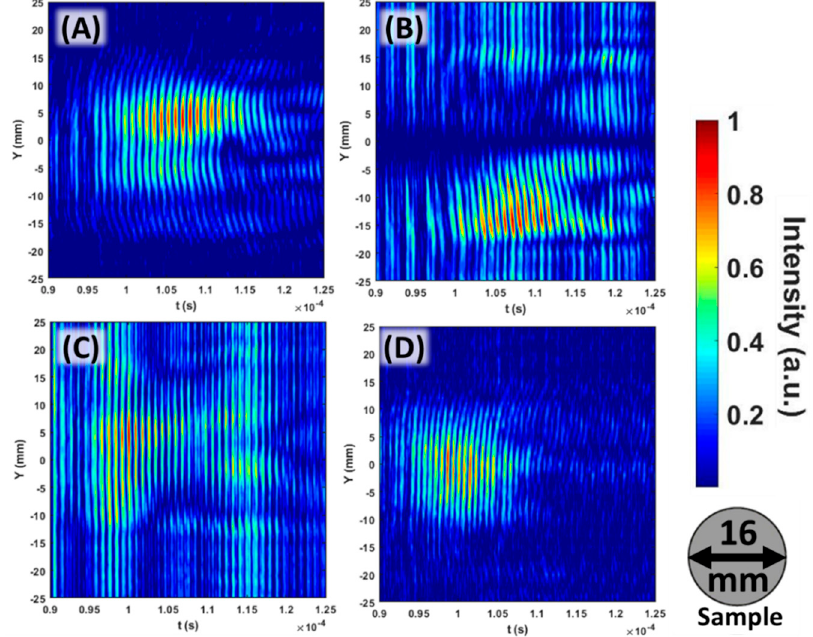
Figure A2. Two-dimensional contour version of the time-of-flight mode detection (Figure 5A–D) using TSSL at near and far distance at 20 °C and 39 °C. ( A ). Far distance (70 mm) between transducer and sample scanned by TSSL at 20 °C. ( B ). Far distance (70 mm) between transducer and sample scanned by TSSL at 39 °C. ( C ). Near distance (60 mm) between transducer and sample scanned by TSSL at 20 °C. ( D ). Near distance (60 mm) between transducer and sample scanned by TSSL at 39 °C.